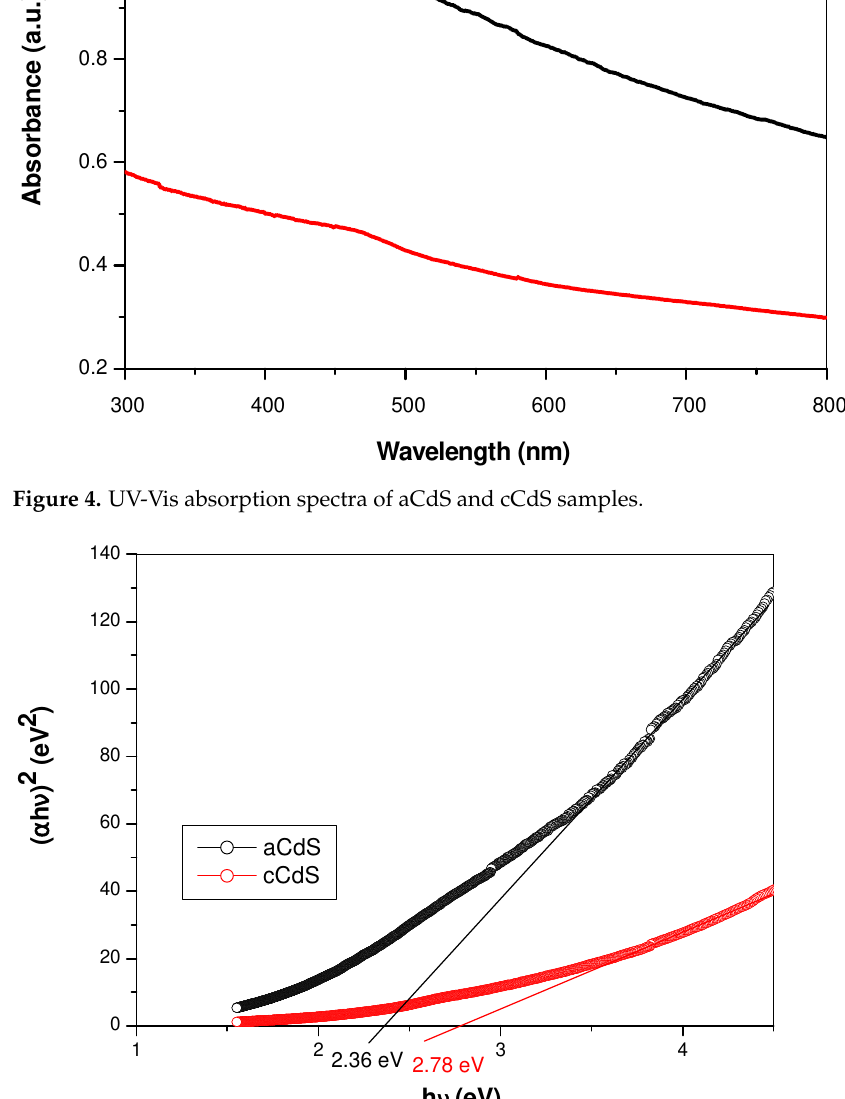
Figure 6. PL emission spectra of aCdS and cCdS samples. The PL spectra of aCdS and cCdS samples are a little different, but both show emission spectra in the visible range. The aCdS sample has broad emission bands at 550 nm (2.2 eV) and 580 nm (2.1 eV), almost consistent with the literature [51]. However, the cCdS sample shows the broad emission bands at 470 nm (2.6 eV) and 490 nm (2.5 eV), which are in accordance with results reported in previous papers [52]. CdS nanoparticles